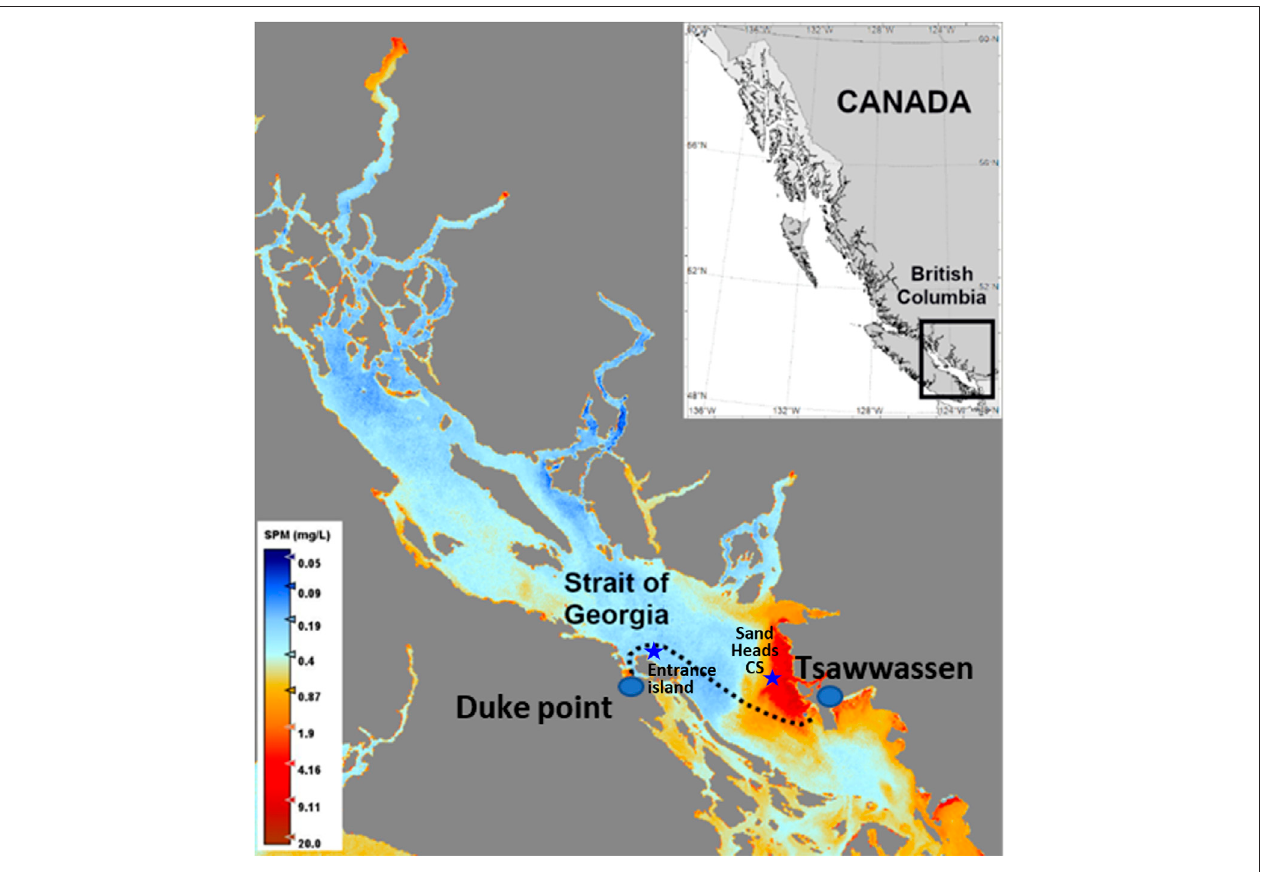
FIGURE 1 | Study area map of the Strait of Georgia plotted from Sentinel-3a, 8-day average of 6 – 13 April 2020, showing Suspended Particulate Matter (SPM) distributioninthestrait.ThedottedlineshowsthecruisetransactoftheQueenofAlbernibetweenDukePoint(VancouverIsland)andTsawwassen(Vancouver).Location of meteorological stations: Entrance Island and Sands Head CS are